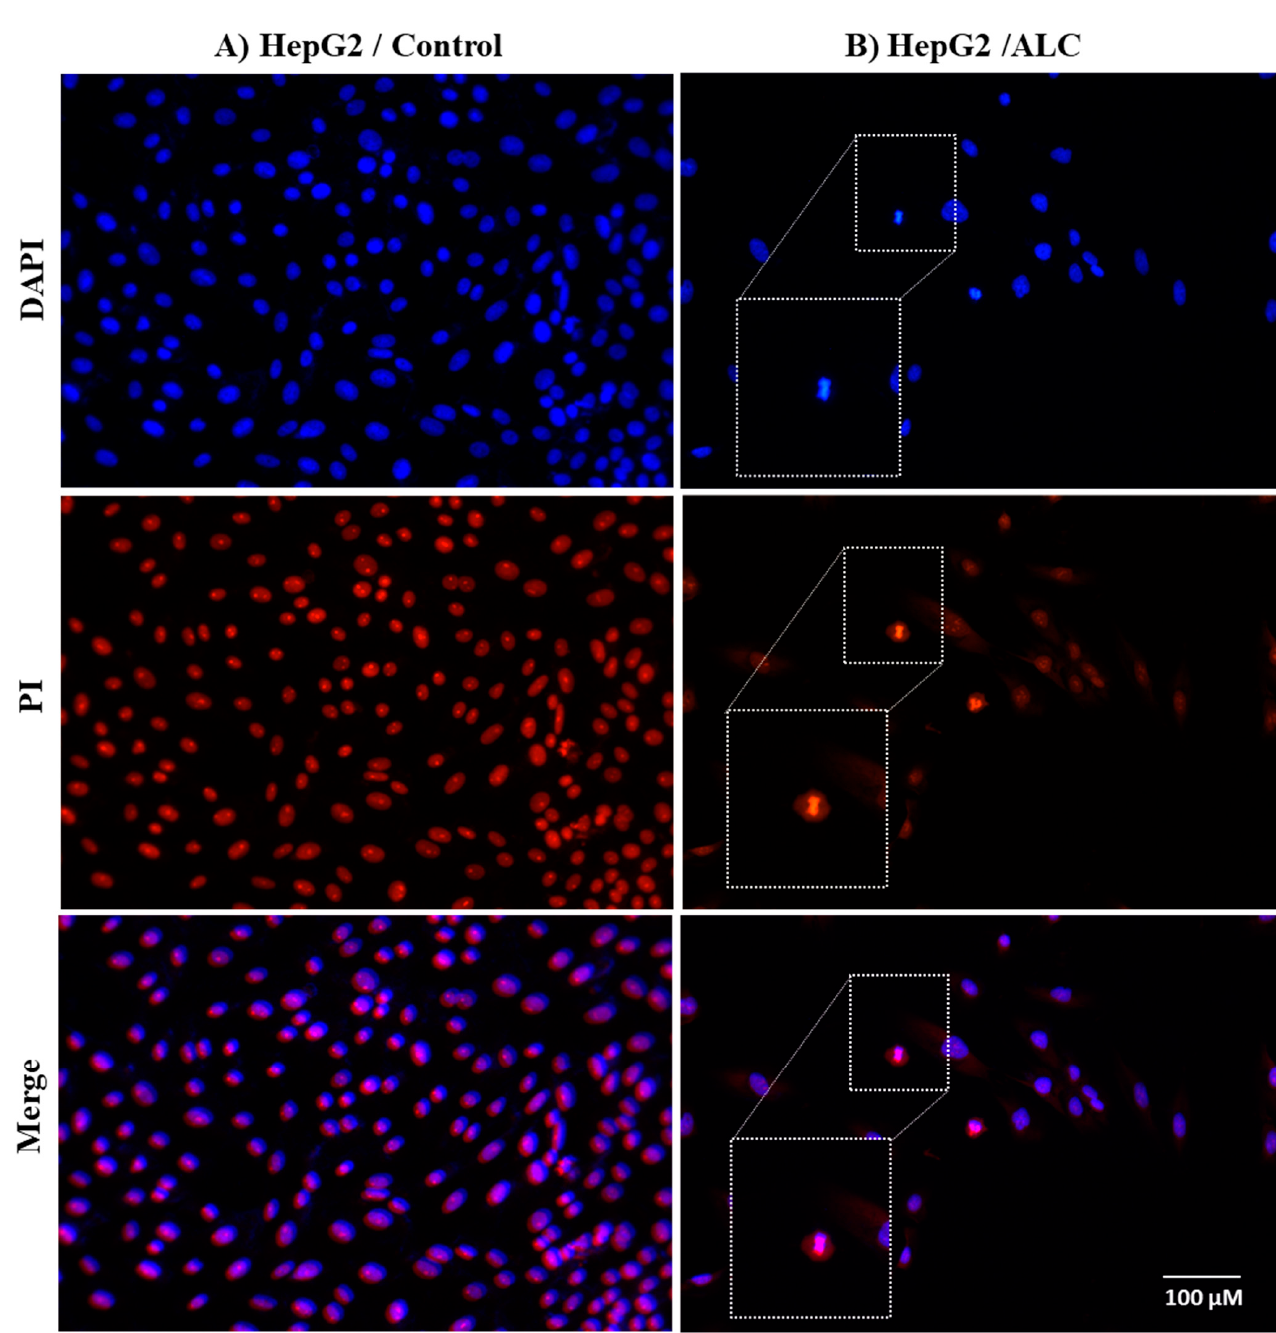
Figure 5. Fluorescent microscopy examination to evaluate apoptotic nucleus morphological changes in HepG2 cells after ALC treatment compared to control. ( A ) control HepG2 cells, ( B ) ALC-treated HepG2 cells. HepG2 cells were treated with their IC 50 concentration of ALC for 48 h and stained with DAPI and propidium iodide (PI). Brightfield images were acquired under fluorescence microscopy with appropriate filters for PI and DAPI. ImageJ was used to overlay images. Rectangles show some cells after being magnified to illustrate the apoptotic effect of ALC on the nucleus.